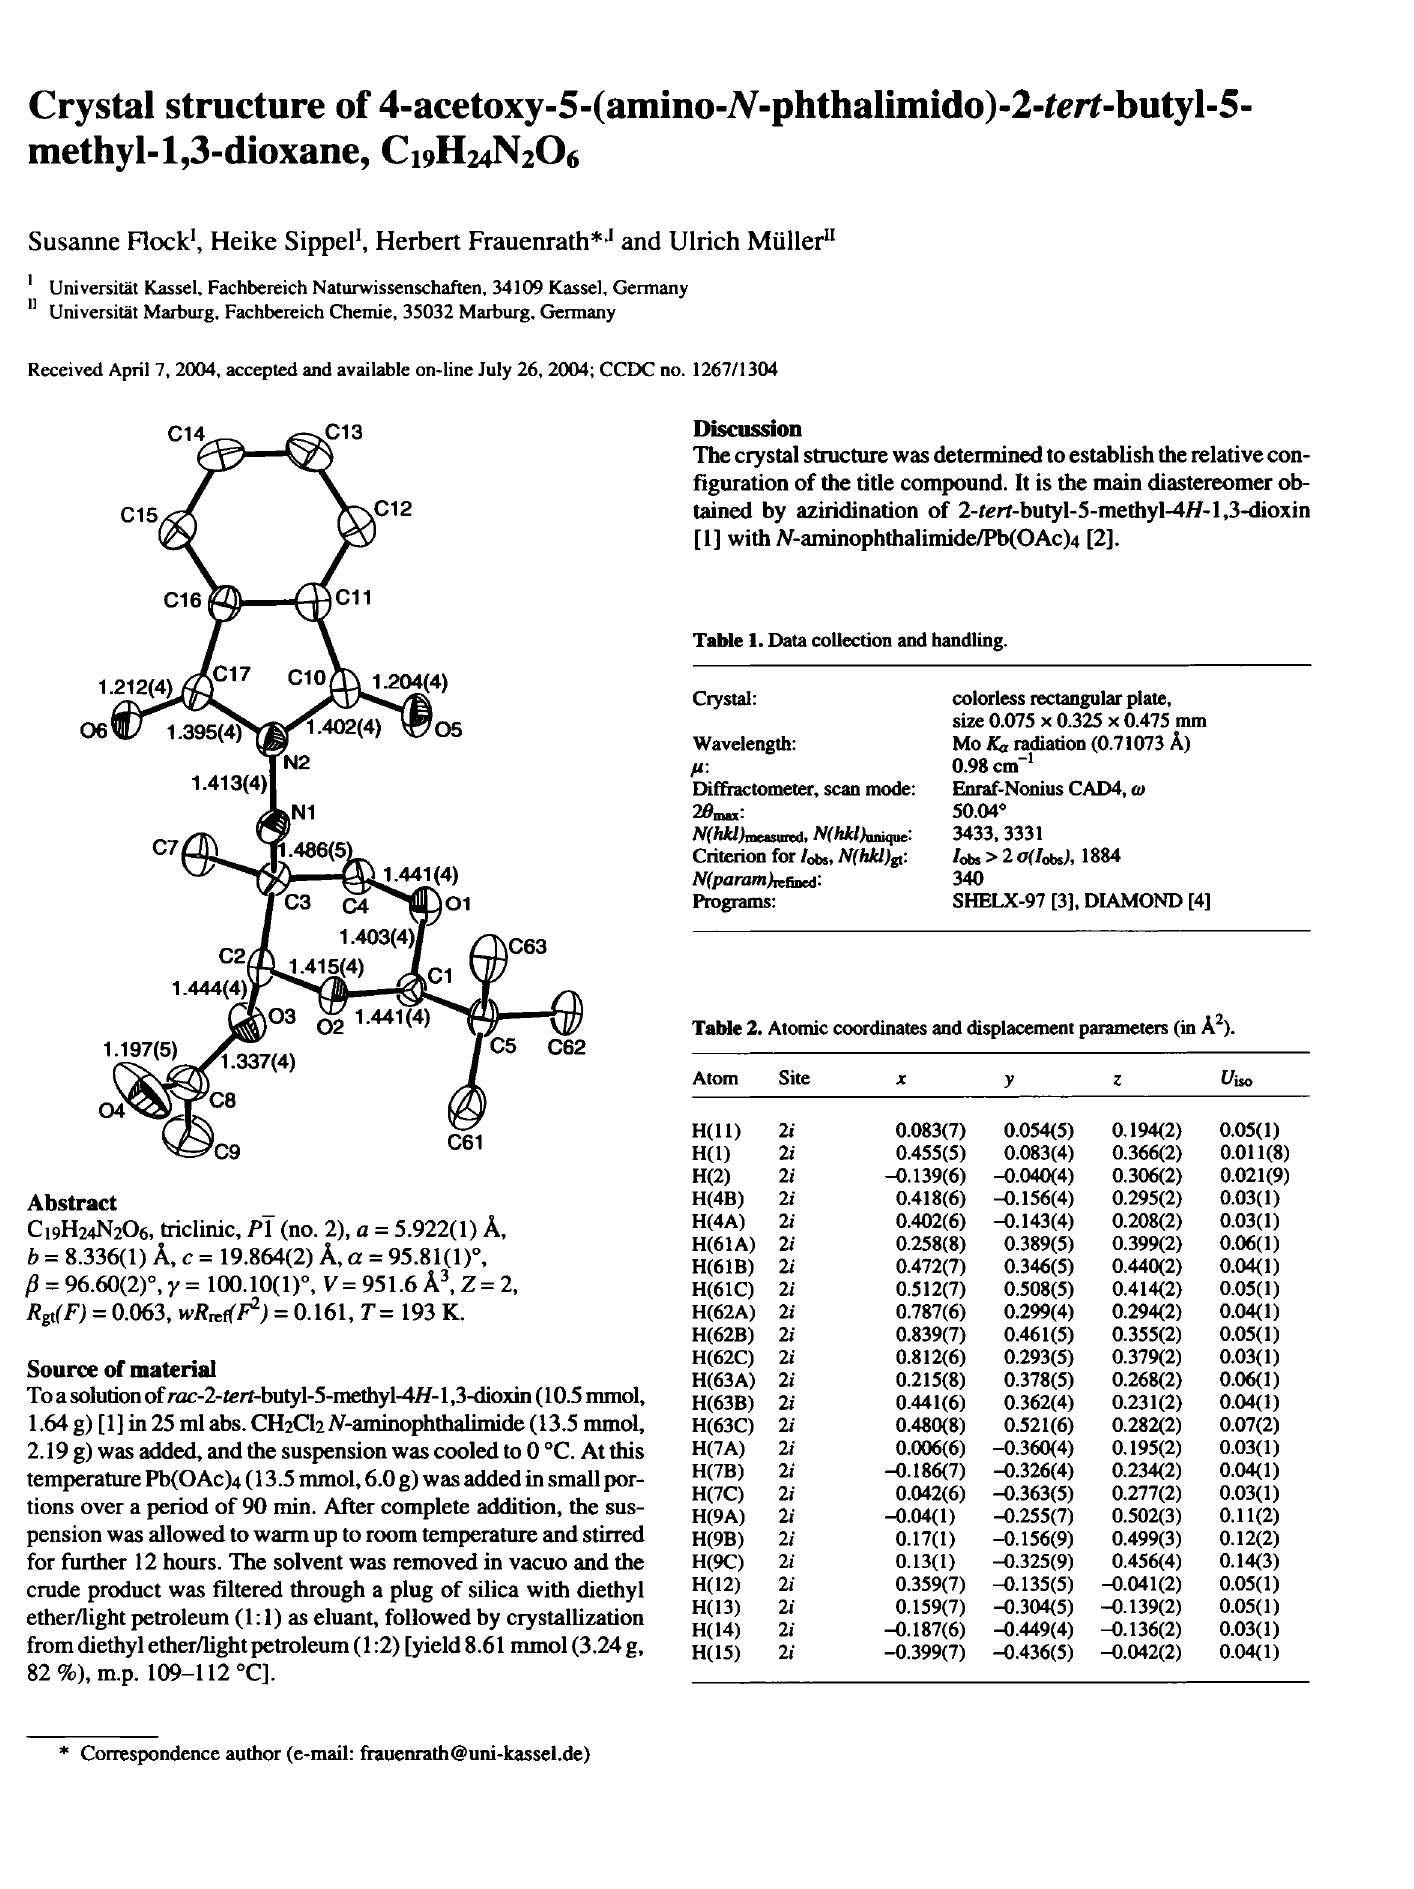
Table 1. Data collection and handling.